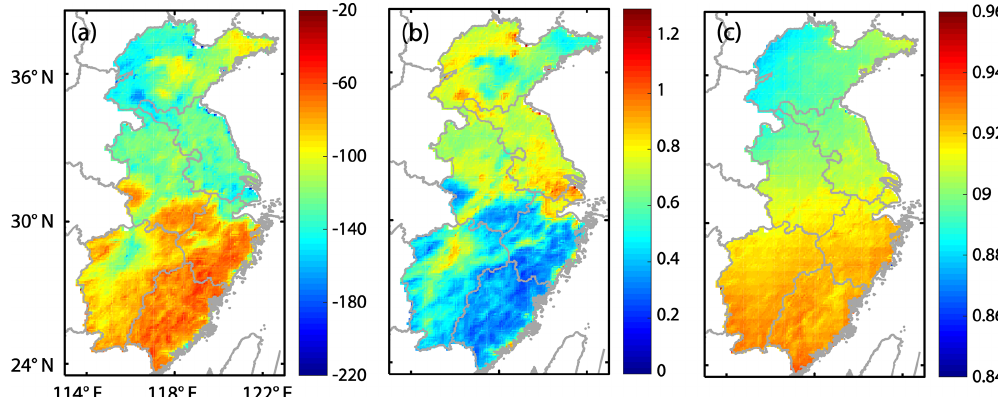
Figure 7. Averaged spatial distribution of (a) ADRF (unit: Wm − 2 ), (b) AOD, and (c) SSA during 2000–2016 in eastern